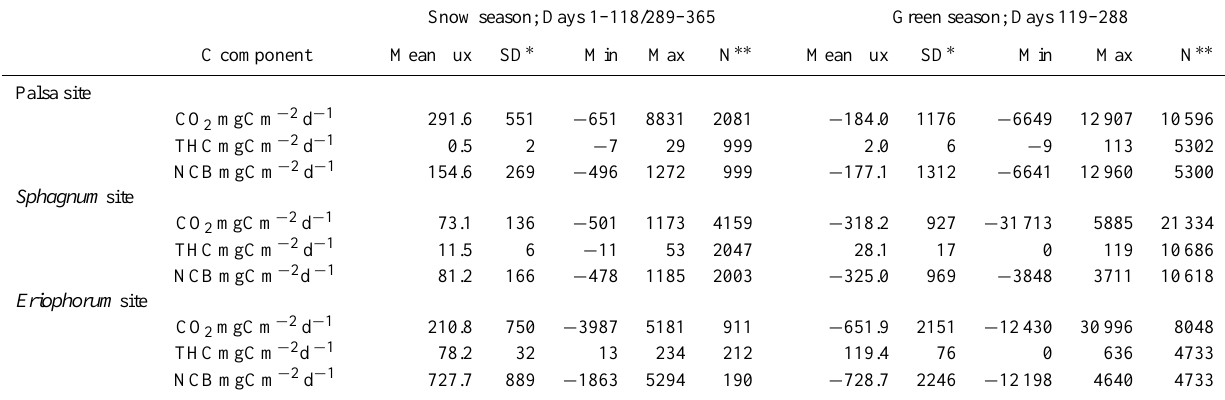
Table 2. Statistics for flux data (mgCm − 2 d − 1 ) from the snow season 1 and the green season 1 , each site analyzed separately. The reason why the mean NCB values are not simply the sum of CO 2 and THC in Table 2 is because the two gas components’ mean values are based on different number of flux measurements. CO 2 , THC, and NCB denote carbon dioxide, total hydrocarbons and net carbon gas balance,